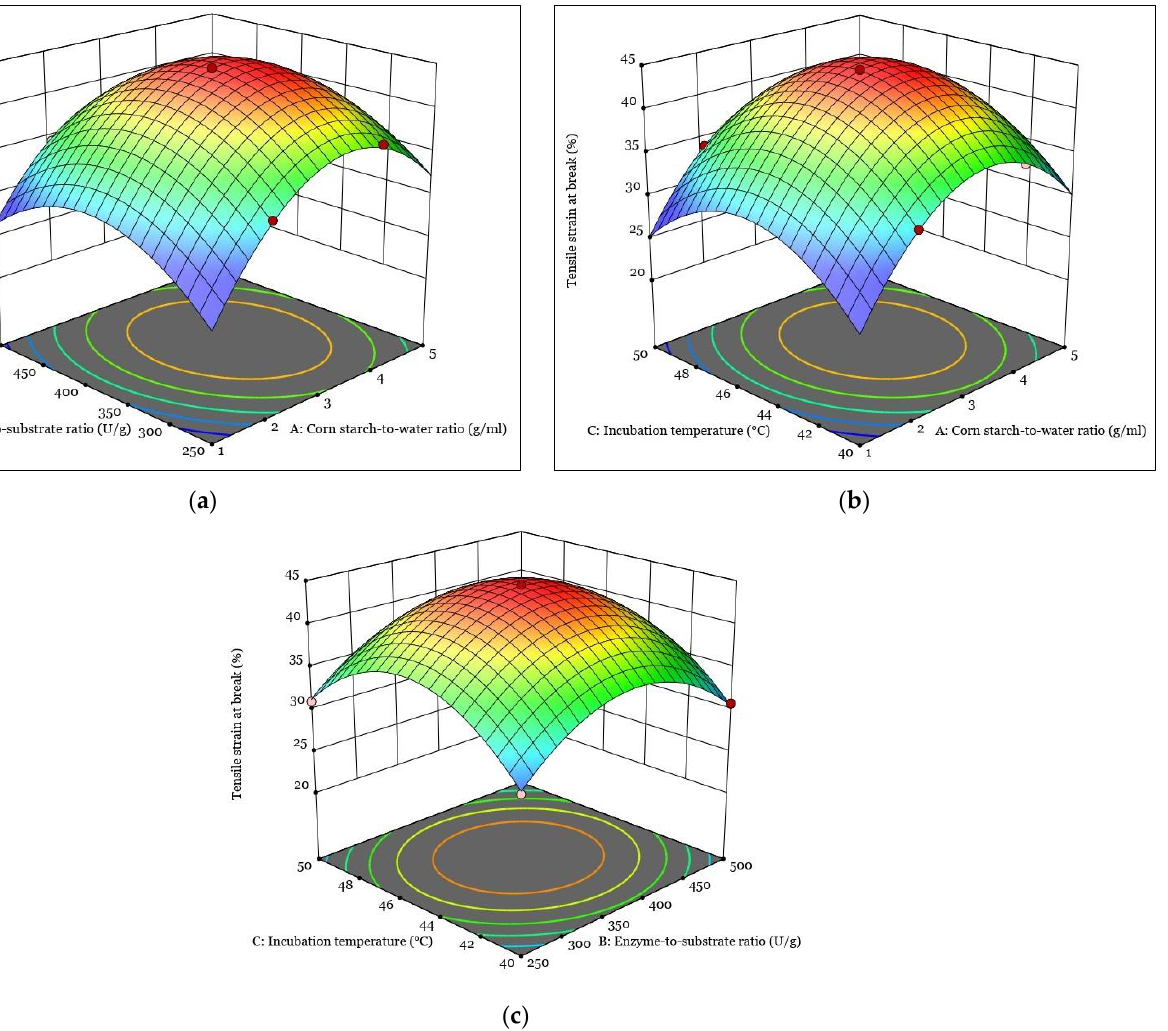
Figure 2. The response surfaces plots of the quadratic and 2FI polynomial models representing the influence of the interaction between independent variables on the tensile strain at break: ( a ) interaction between A and B; ( b ) interaction between A and C; ( c ) interaction between B and C. The effect of the enzyme-to-substrate ratio and incubation temperature on DH